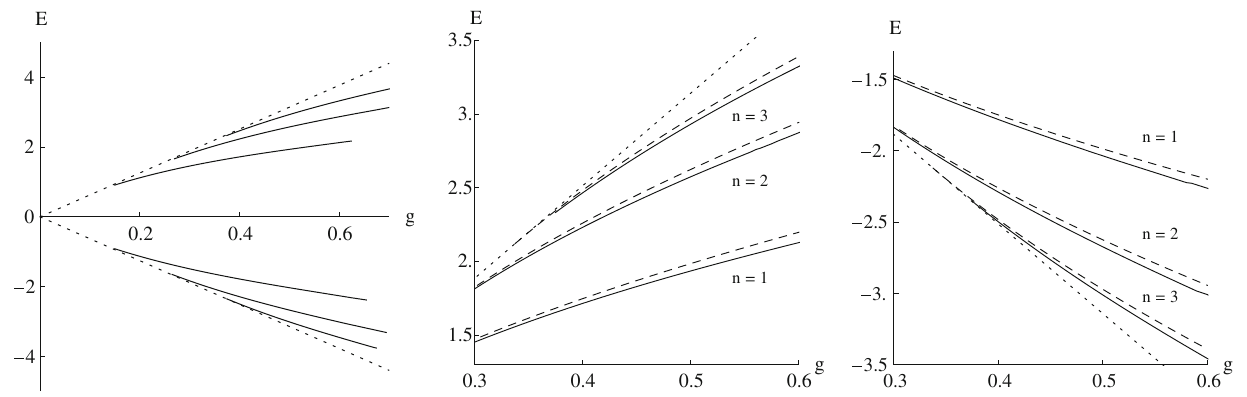
Fig. 1 The fermionic bound energies as a function of g , for the soliton with winding number one. Left graph : solid curves depict the positive and negative fermionic bound energies, in the dynamical model. Middle graph : solid and dashed curves depict positive fermionic bound ener-